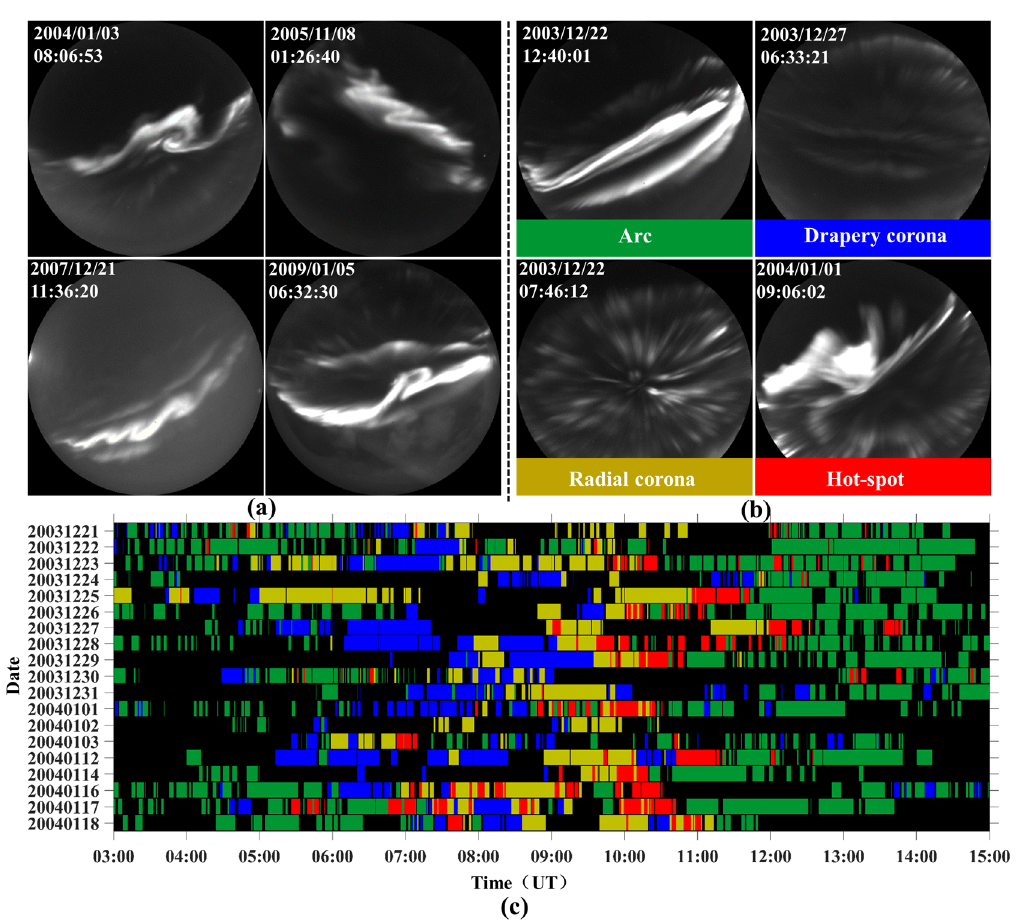
Figure 5. Data: ( a ) Some ASI images at 557.7 nm that contain fold structures. ( b ) ASI images at 557.7 nm of four dayside auroral types. ( c ) The annotation of the four auroral types.